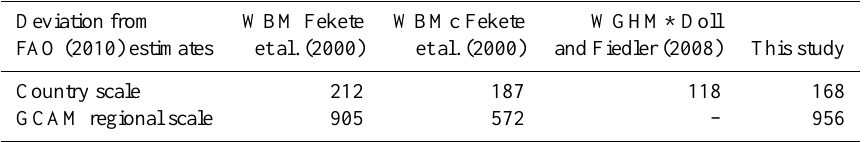
Table 3. Estimates of models’ departure (RMSE) from FAO (2010) estimates at the country scale (only countries for which all four models have values are used to estimate the RMSE values) and the GCAM scale; units are in km 3 yr − 1 .